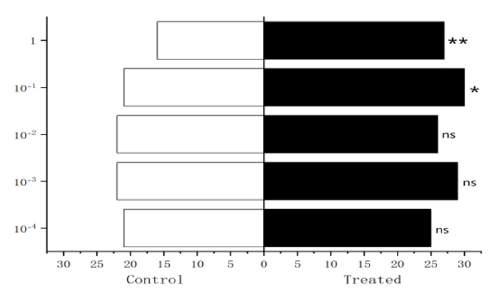
Figure 28. Behavioral responses to 1-octen-3-ol in male W. magnifica .